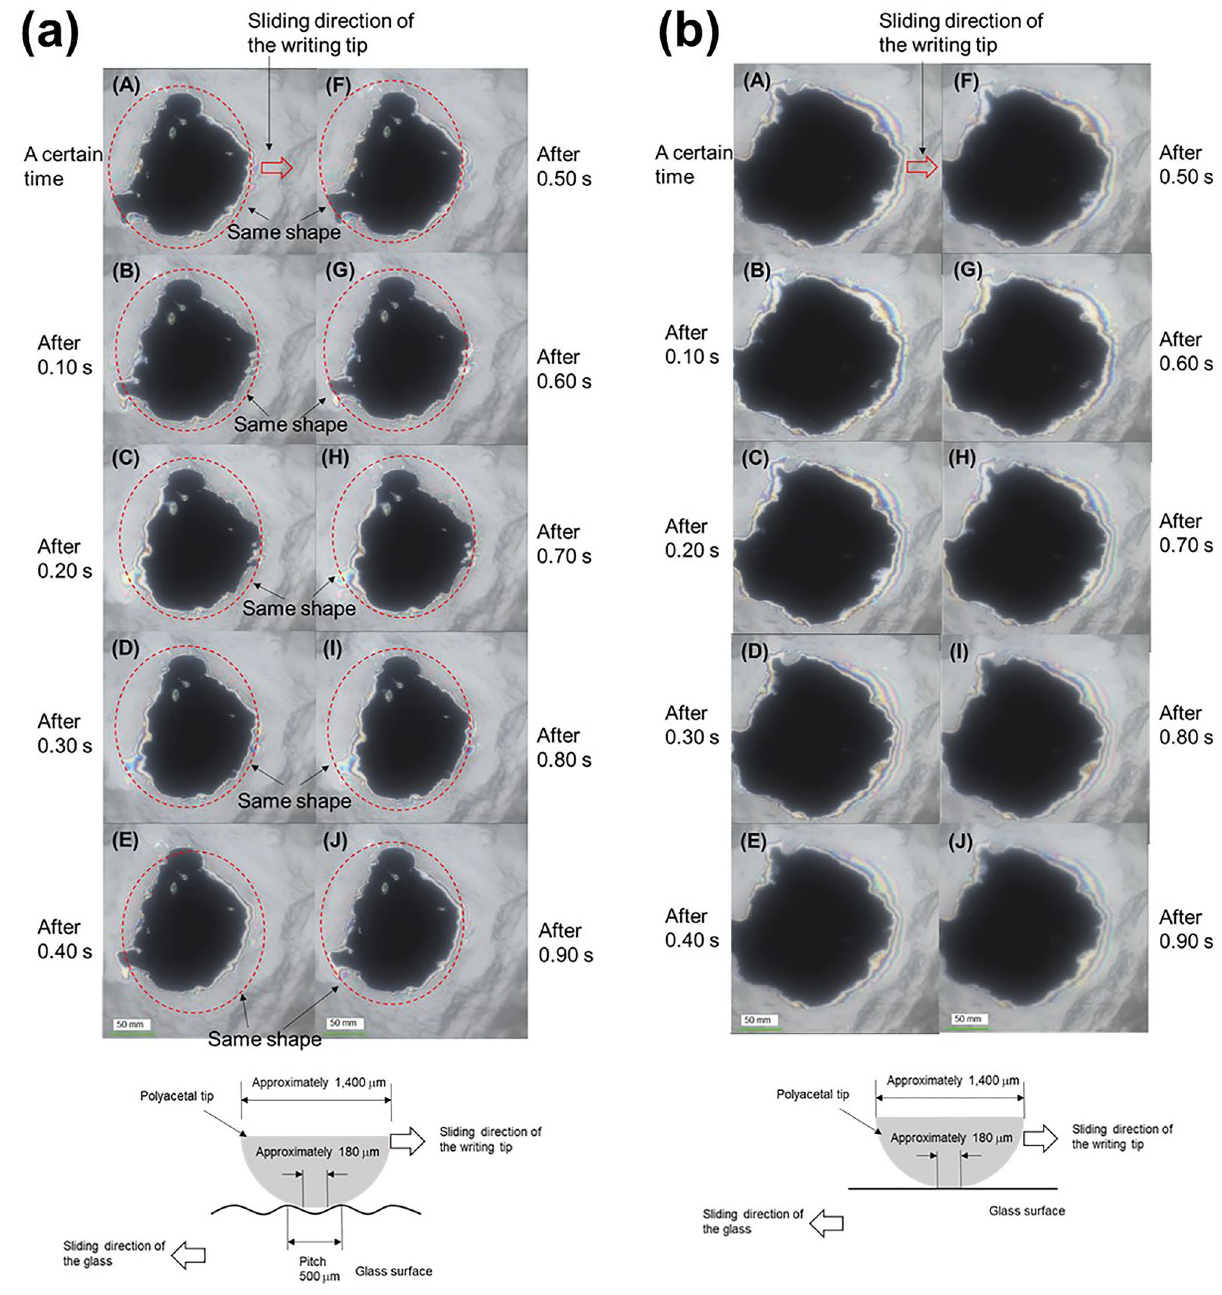
Figure 5. Observations of the contact area between the polyacetal and glass surfaces during sliding motion (( a ) Stripe pattern with 0.5 mm spacing and 1463 nm, ( b ) flat glass), and illustration of the relationship between the polyacetal and each glass